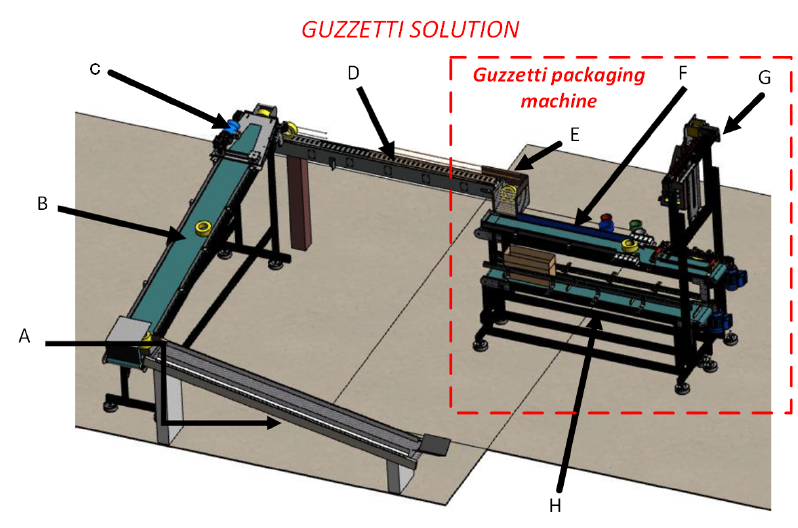
Figure 3. (A) Guzzetti machine exit conveyor; (B) Label conveyor; (C) Labeling machine; (D) Con- veyor belt for the tape changer; (E) Tape turner; (F) Conveyor belt Guzzetti; (G) Pick-up system; and (H) Conveyor belt for